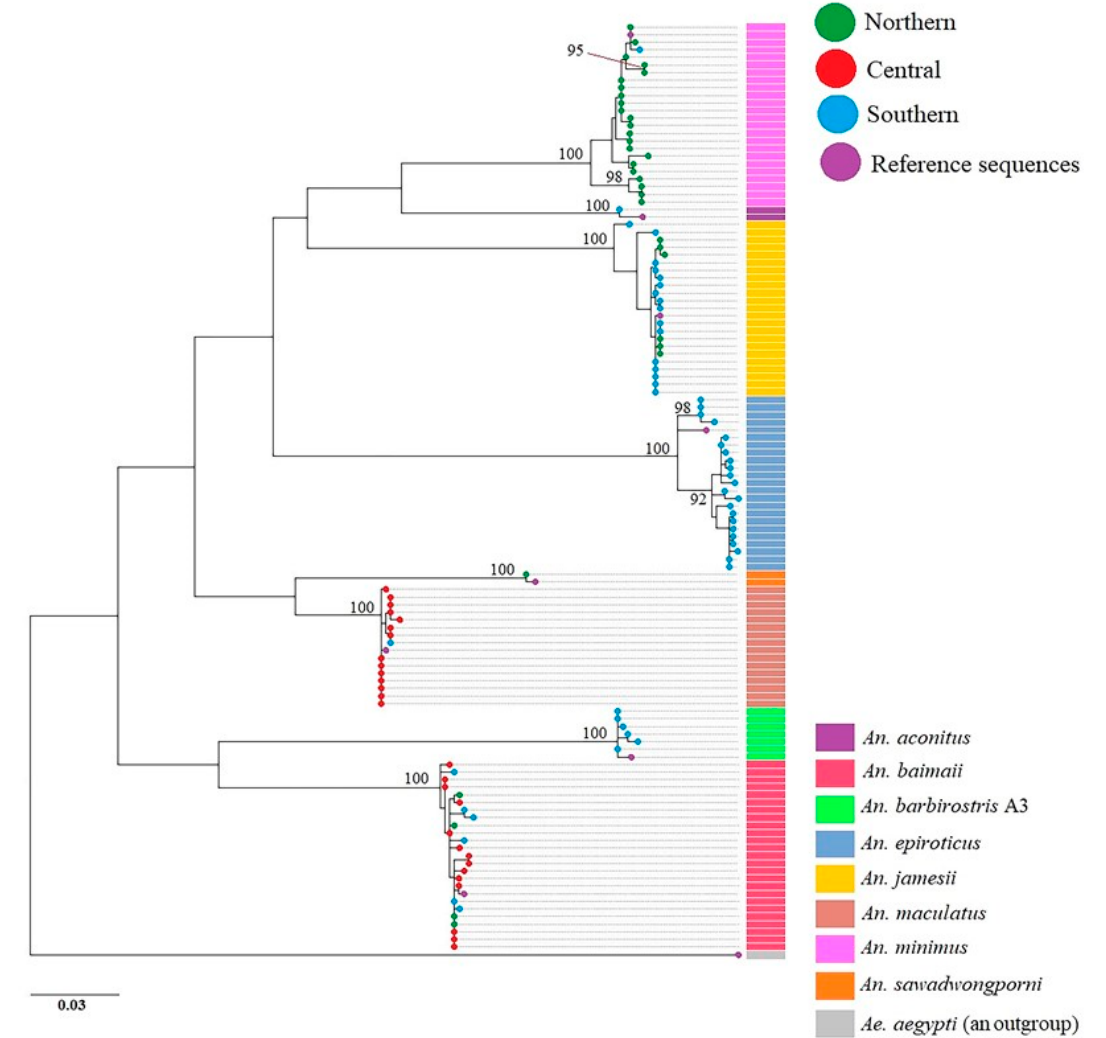
Figure 2. Maximum likelihood tree of eight Anopheles species identified in this study. Color bands indicate each species of Anopheles mosquito. The small colored circles represent the areas in which the samples were collected. Bootstrap values (1000 replicates) >90% are shown at the nodes. Eight sequences obtained from GenBank were used as species references, including An. baimaii (GenBank